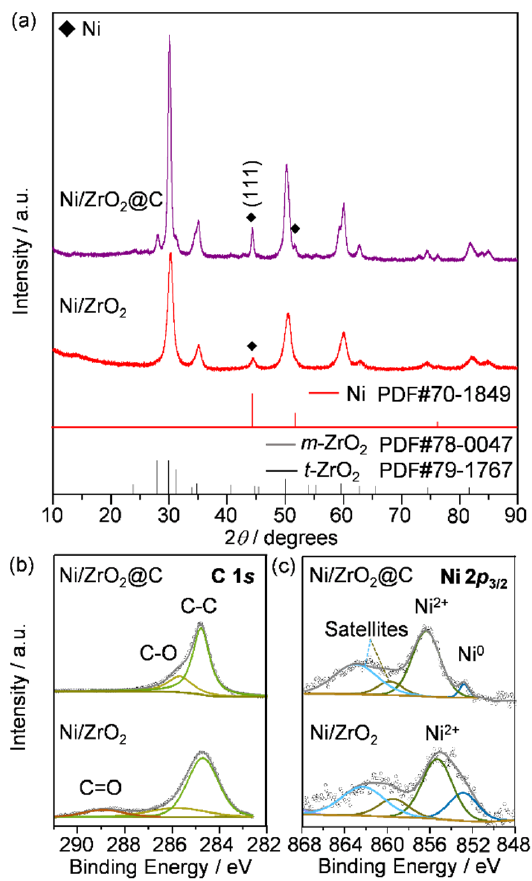
Figure 2. ( a ) XRD patterns, and ( b ) the C 1 s and ( c ) Ni 2 p 3/2 XPS spectra of Ni/ZrO 2 and Ni/ZrO 2 @C.